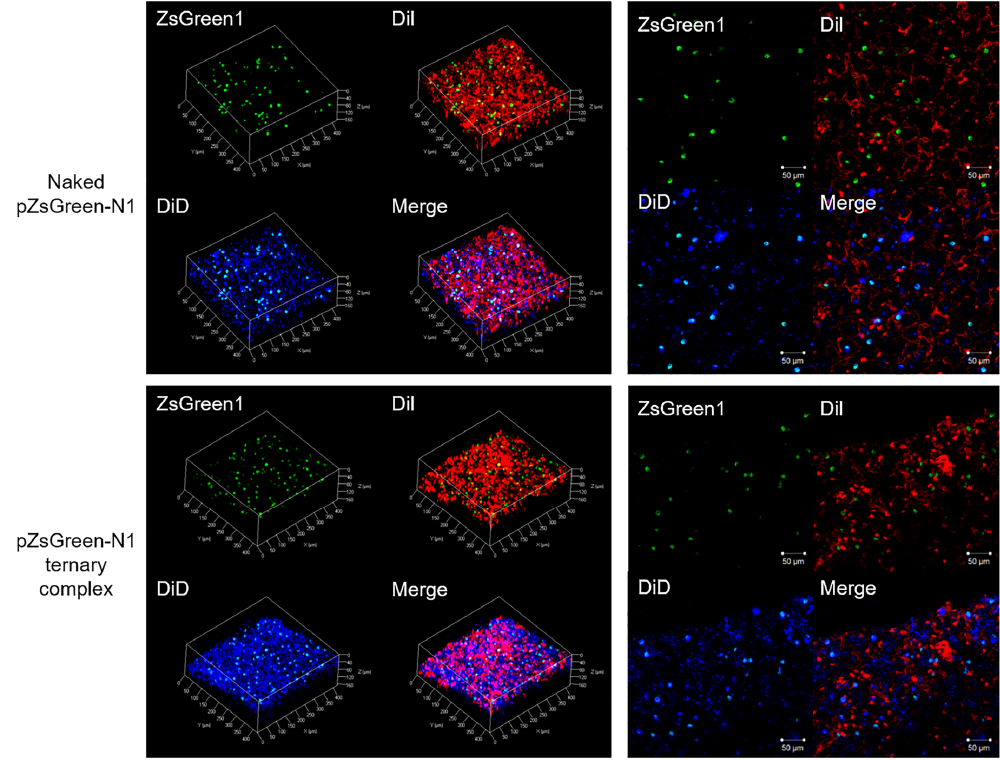
Figure 3. Spatial distribution of gene expression. Naked pZsGreen1-N1 and the pZsGreen1-N1 ternary complex were administered to ddY mice via the intrapulmonary route. Mice were sacrificed 24 h later and the lungs were subjected to the tissue cleaning method. Fluorescence was observed by confocal laser scanning microscopy. Green: ZsGreen1 expression, Red: DiI-stained vascular cells, and Blue: DiD-stained surface cells of the alveoli.